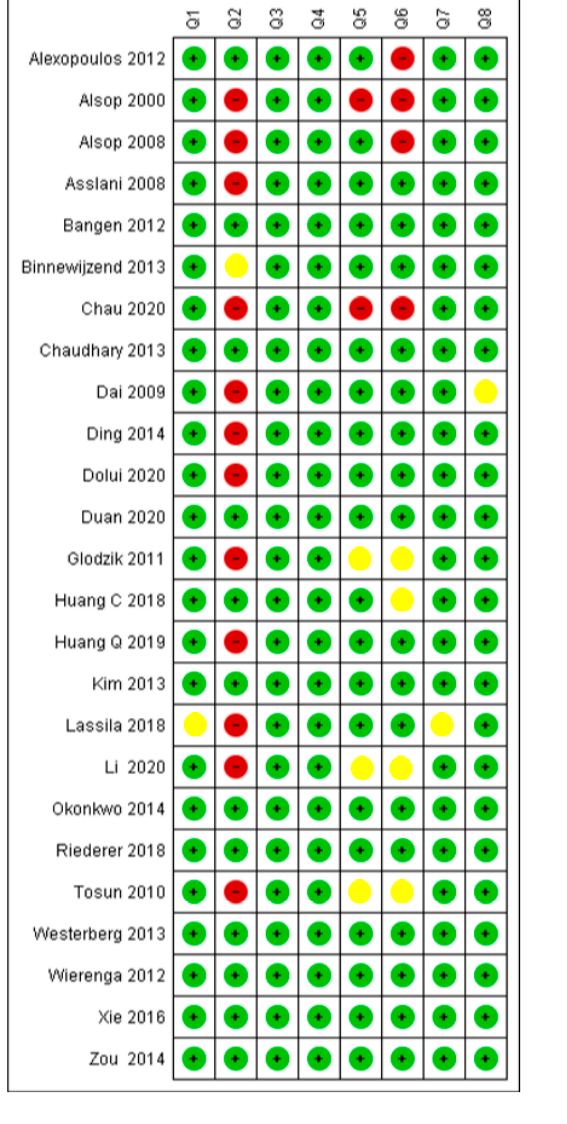
Figure 2. Critical appraisal of included studies (Alexopoulos 2012 [33], Alsop 2000 [34]. Alsop 2008 [35]. Asslani 2008 [36], Bangen 2012 [37], Binnewijzend 2013 [38], Chau 2020 [39], Chaydhary 2013